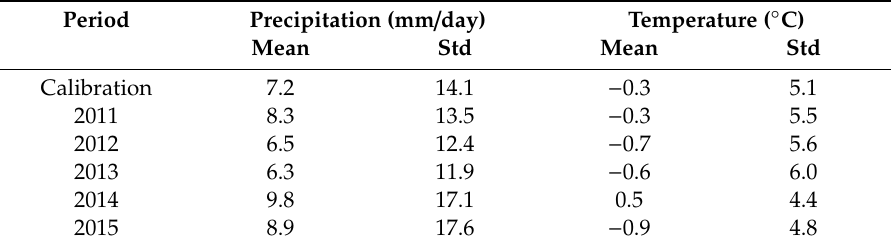
Table 1. Daily meteorological conditions (mean and standard deviation (Std)) for the calibration period and each year in the validation